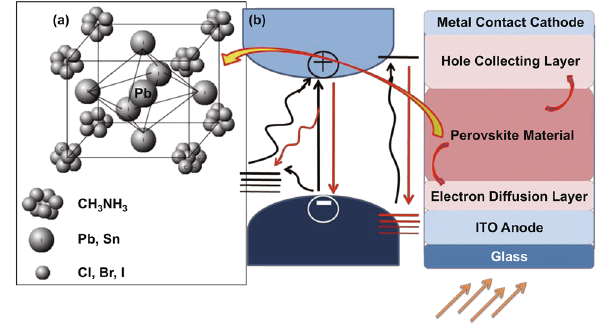
Fig. 1 a Simulated crystal structure of CH 3 NH 3 BX 3 obtained from the diffraction pattern and b electron–hole diffusion diagram in the